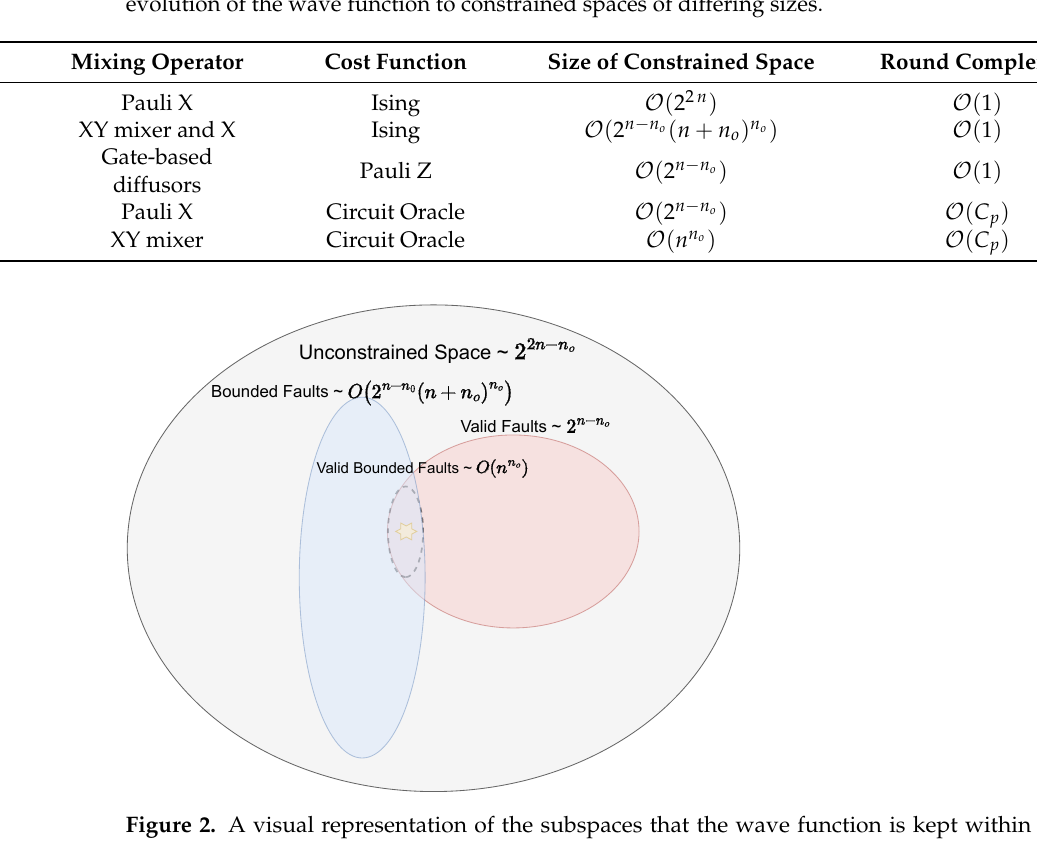
Table 2. Depending on our selection of mixing and phase-separating operators, we can constrain the evolution of the wave function to constrained spaces of differing sizes.